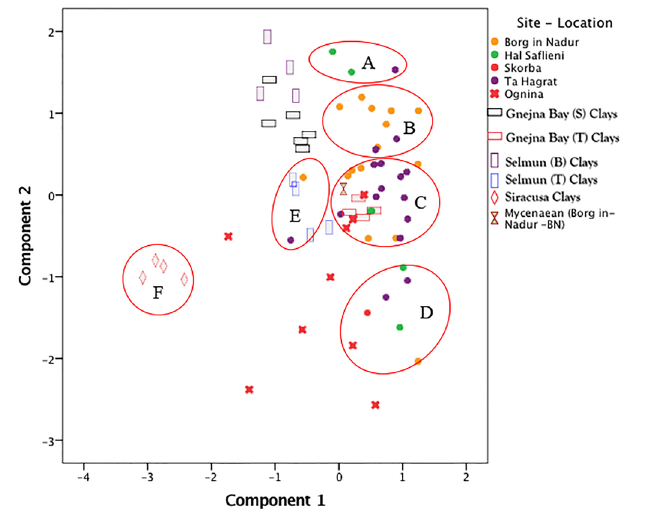
Figure 6. Bivariate scatterplots of principal component scores for Borġ in-Nadur phase samples and Maltese and Sicilian clay samples. Ellipses are made artificially.